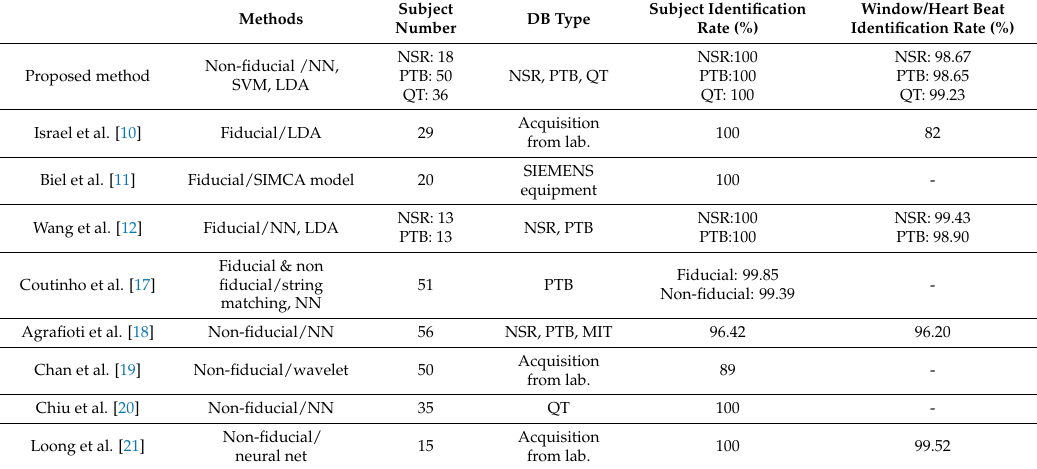
Figure 7. Random selection results: ( a ) NSR random selection result; ( b ) PTB random selection result; and ( c ) QT random selection result. Table 8. Comparison of results with other